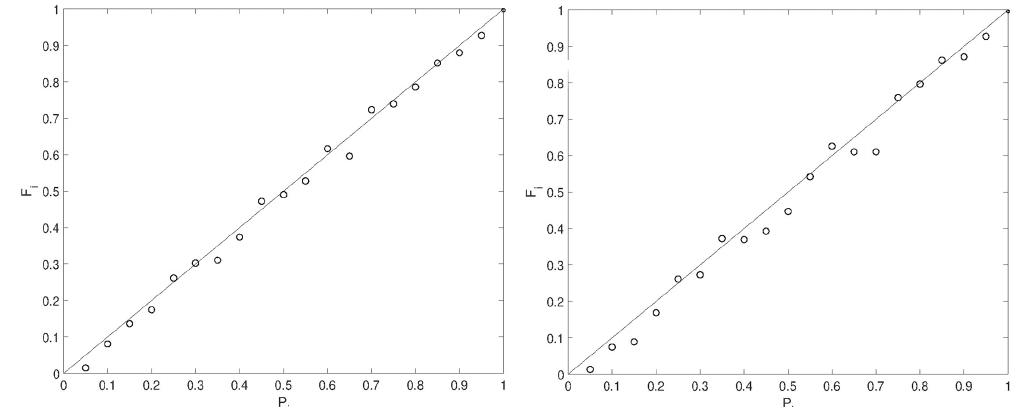
Figure 5. Example of the reliability plots for the verification of the synthetic probabilistic flood maps of the first two synthetic SAR images. On the x axis is the probability range ( P i ) and on the y axis is the fraction of pixels within the probability range of the probabilistic flood map observed as flooded in the true binary flood map ( F i ). The probabilistic flood maps are statistically reliable because the points align along the 1 : 1 line.